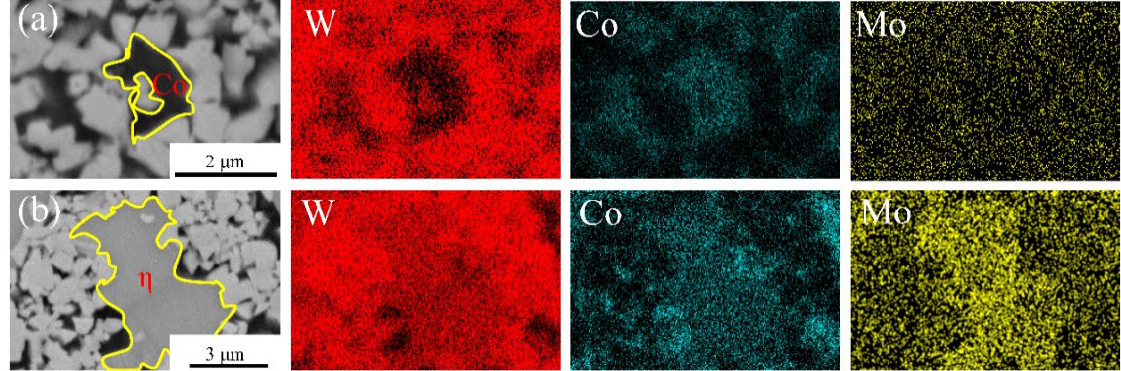
Figure 7. Mapping of elements distribution of the 2.5Mo-5.0C sample. ( a ) Co phase and ( b ) eta phase.